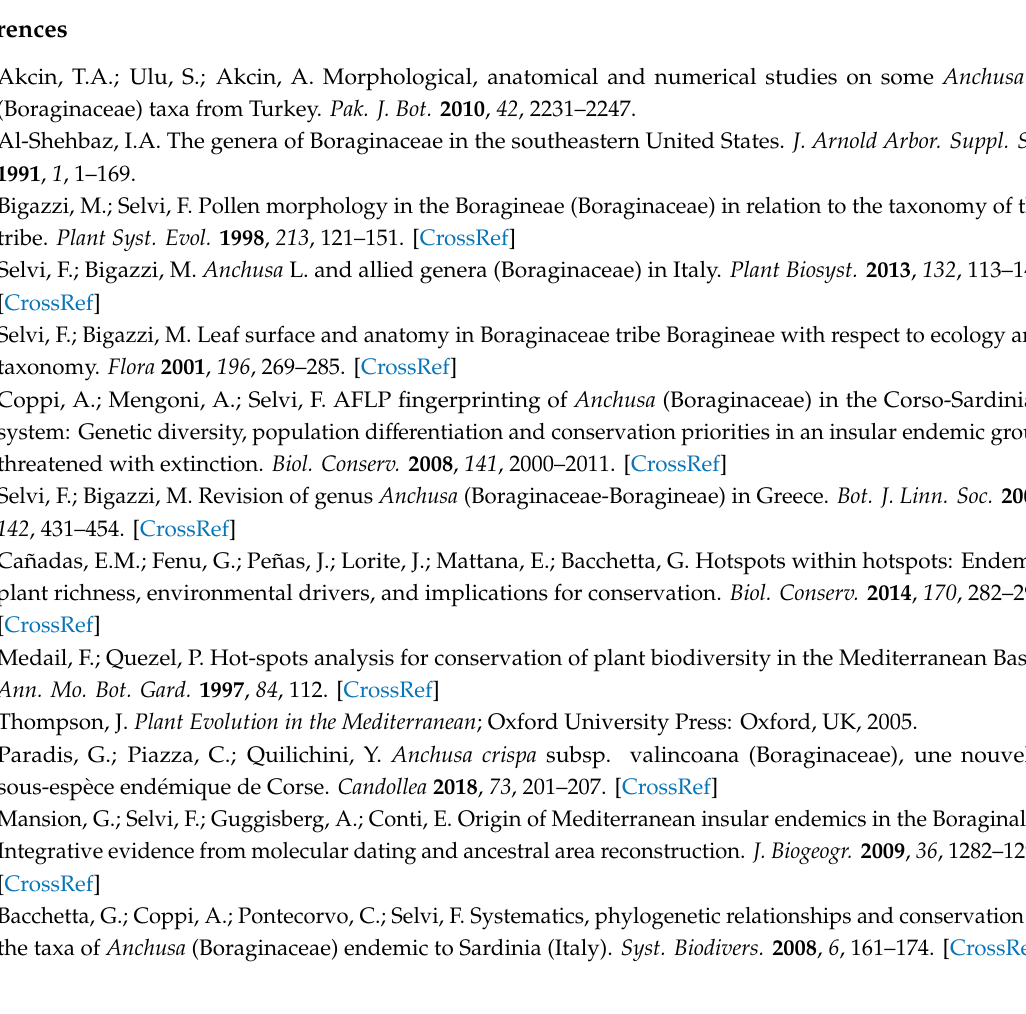
Table S1: Importance of principal components, Table S2: Percentage of correct classification of the 17 Anchusa populations analyzed. In bold, the correct classification; in parentheses, the number of analyzed seeds, Table S3: Accessions of Anchusa taxa with the collecting localities and number of seeds analyzed in this study. Accession numbers refer to the Sardinian Germplasm Bank (BG-SAR) of Hortus Botanicus Karalitanus of the University of Cagliari, Figure S1: Percentage of explained variance of the first 10 principal components, Figure S2: Contribution of variables to PC1. Figure S3: Contribution of variables to